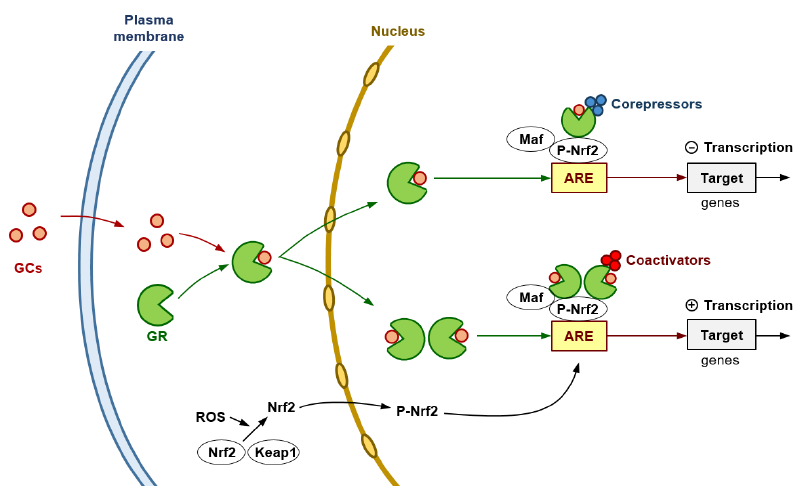
Figure 2. Glucocorticoids and the Antioxidant Defense of Melanoma Cells. The GR is encoded by the NRC31 gene which can produce a number of receptor isoforms, the GRα being the primary receptor involved in glucocorticoid (GC) signaling. The cytosolic GR complexes with different proteins, i.e., Hsp90, Hsp70 and the FK506-binding protein 4. GCs diffuse through the plasma membrane into the cytoplasm and binds to the GR resulting in the release of heat shock proteins. Based on the two-part model proposed by Gerber et al. [142], the cytoplasmic GR interacts with glucocorticoids, thus causing a conformational change and nuclear translocation. GR interacts with both the DNA and other transcriptional machinery to orchestrate its genomic effects through three main mechanisms: direct binding to glucocorticoid response elements, transcription factor tethering, and binding of composite elements within the DNA [143]. Hypothetically, at high pharmacological levels of GCs, primary repression could result from an excessive amount of GR monomers tethering to the ARE-Nrf2 complex (Nrf2 dimerizes with a basic region-leucine zipper bZIP protein and binds to the ARE to activate gene transcription), then leading to recruitment of corepressors. In this mechanism, GR associates with NF- κ B or AP-1 [144,145], thus resulting in repression of their activity in a process attributed to recruitment of transcriptional corepressors such as the nuclear receptor co-repressor 1 and the histone deacetylase 2 [146]. At lower extracellular levels of GCs (pathophysiological levels), GR homodimers (predominantly formed) would recruit coactivators (such as the steroid receptor coactivator-1, SRC-1; or the GR-interacting protein-1, GRIP-1) [147] and induce the transcription of genes encoding antioxidant/defense enzyme activities. This double model may help to reconcile the controversy in the results obtained by different